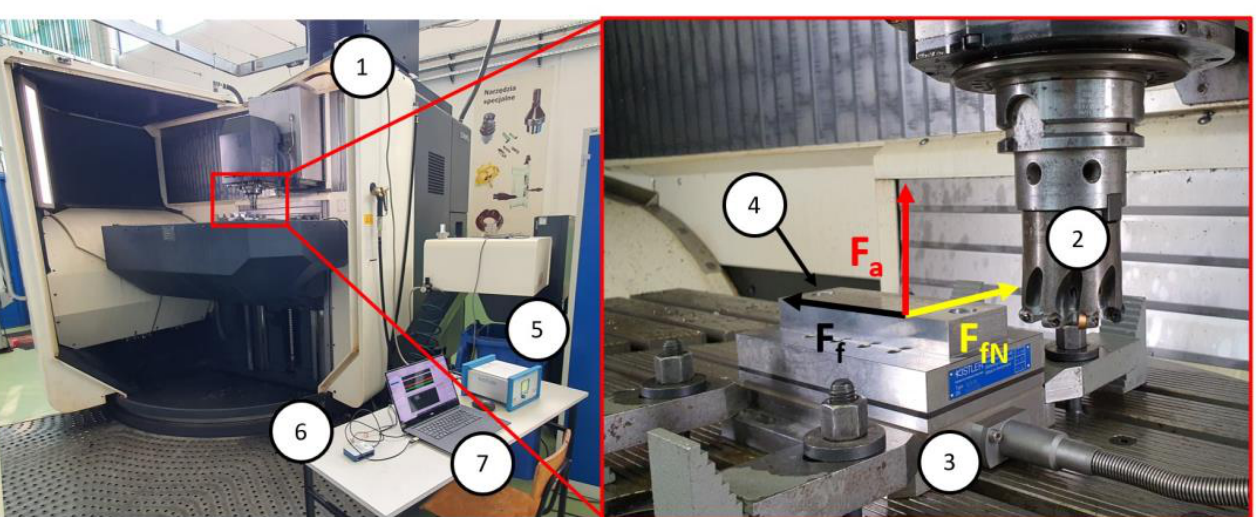
Table 1. Chemical composition of 42CrMo4 steel (%).